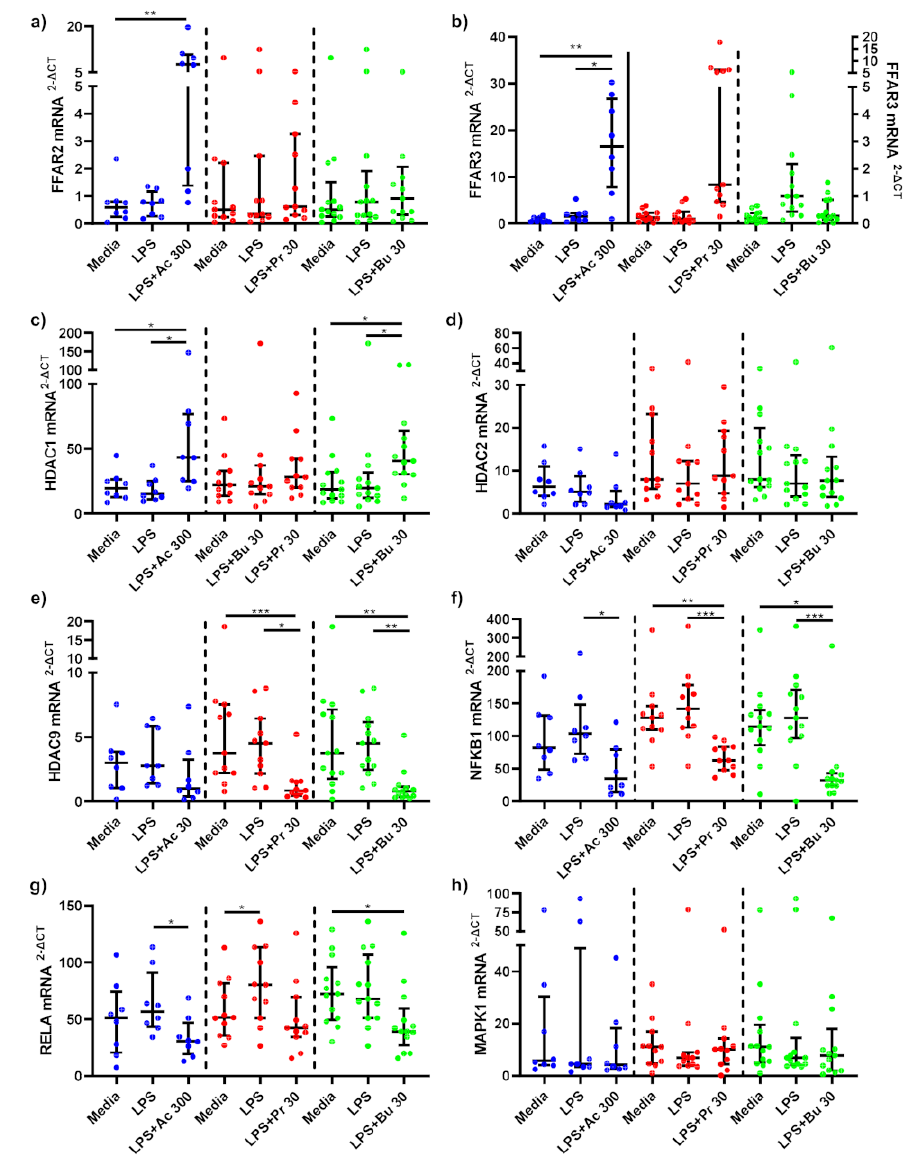
Figure 6. mRNA expression response of LPS-stimulated adipose tissue macrophages following short- chain fatty acid treatments. mRNA expression of ( a ) FFAR2, ( b ) FFAR3, ( c ) HDAC1, ( d ) HDAC2, ( e ) HDAC9, ( f ) NFKB1, ( g ) RELA, and ( h ) MAPK1 produced by macrophages stimulated with LPS (1 ng/mL) alone or treated simultaneously with sodium acetate ( n = 10) 300 mM or sodium propionate ( n = 11) 30 mM or sodium butyrate ( n = 13) 30 mM following 15 h incubation. Parametric data analysed by RM one-way ANOVA and post hoc analysis Tukey’s multiple comparison test, non-parametric by the Friedman test and post hoc analysis by Dunn’s multiple comparisons test. LPS; lipopolysaccharide, Ac; acetate, Pr; propionate, Bu; butyrate. * p < 0.05, ** p < 0.01 and *** p < 0.001. Data expressed as the mean